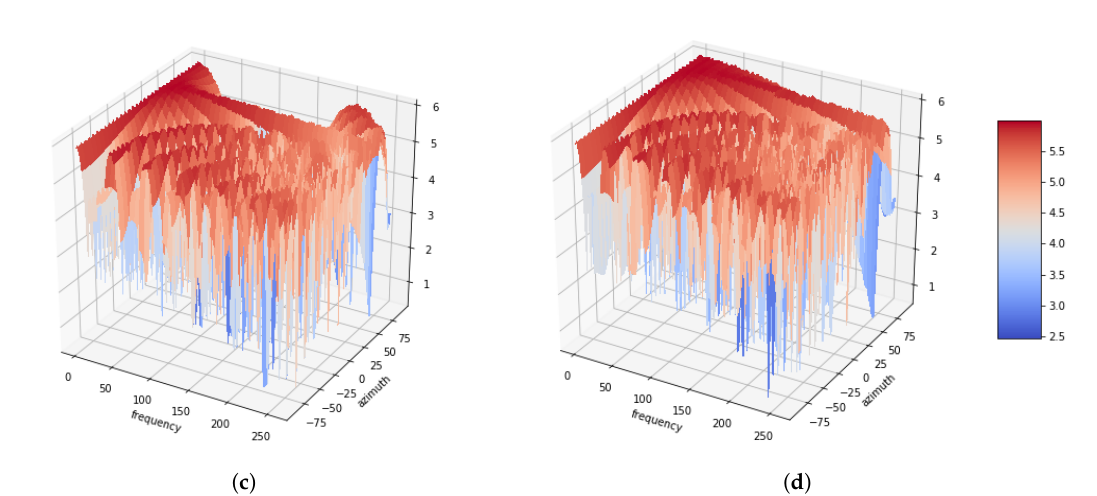
Figure 1. Azimuth-frequency representation of white noise depending as a function of the azimuth.